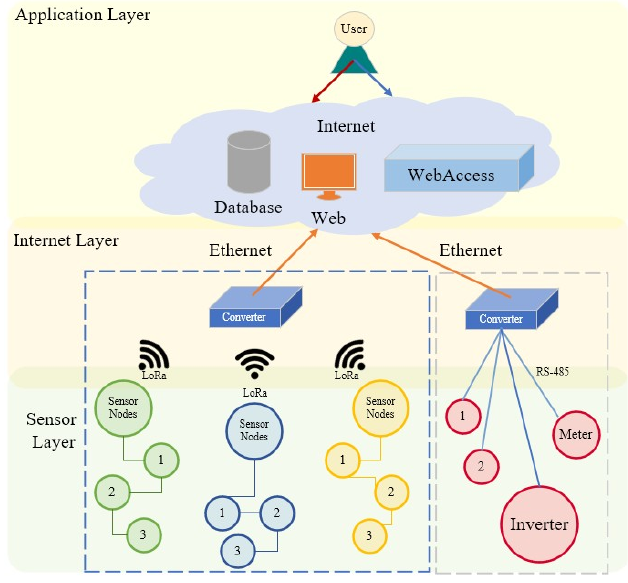
Figure 1. Structure of the campus green information system (the 1 to 3 stands for different sensor nodes).